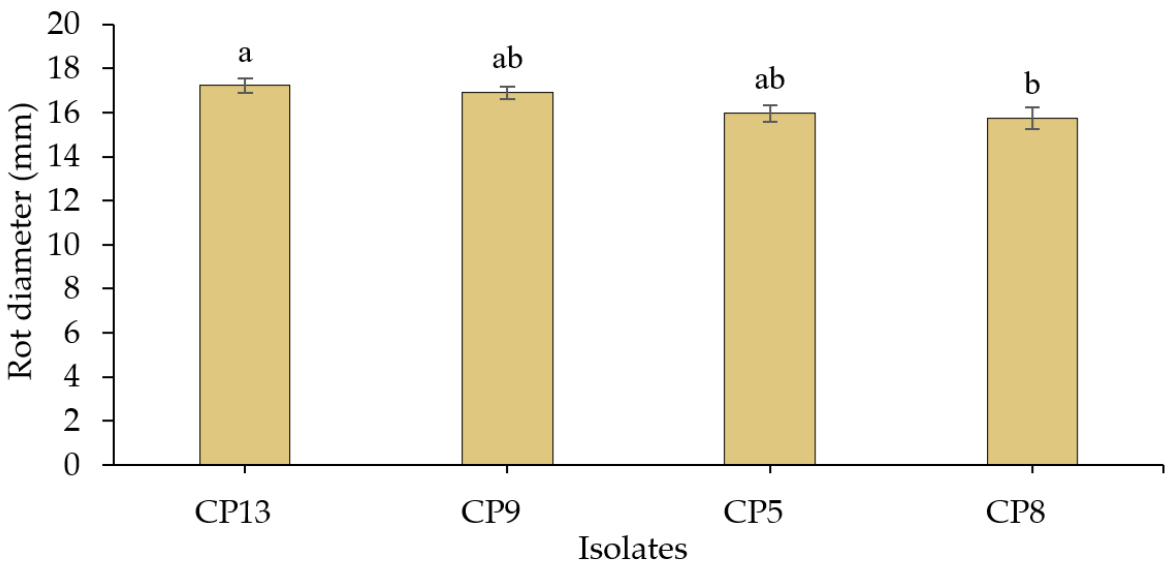
Figure 3. Disease severity (rot diameter) of Chilean CP13, CP9, CP5, and CP8 isolates of Phlyctema vagabunda in ‘Cripps Pink’ apples incubated at 20 °C for 20 days. Letters on bar indicate statistical differences between isolates after Tukey test ( p < 0.05).